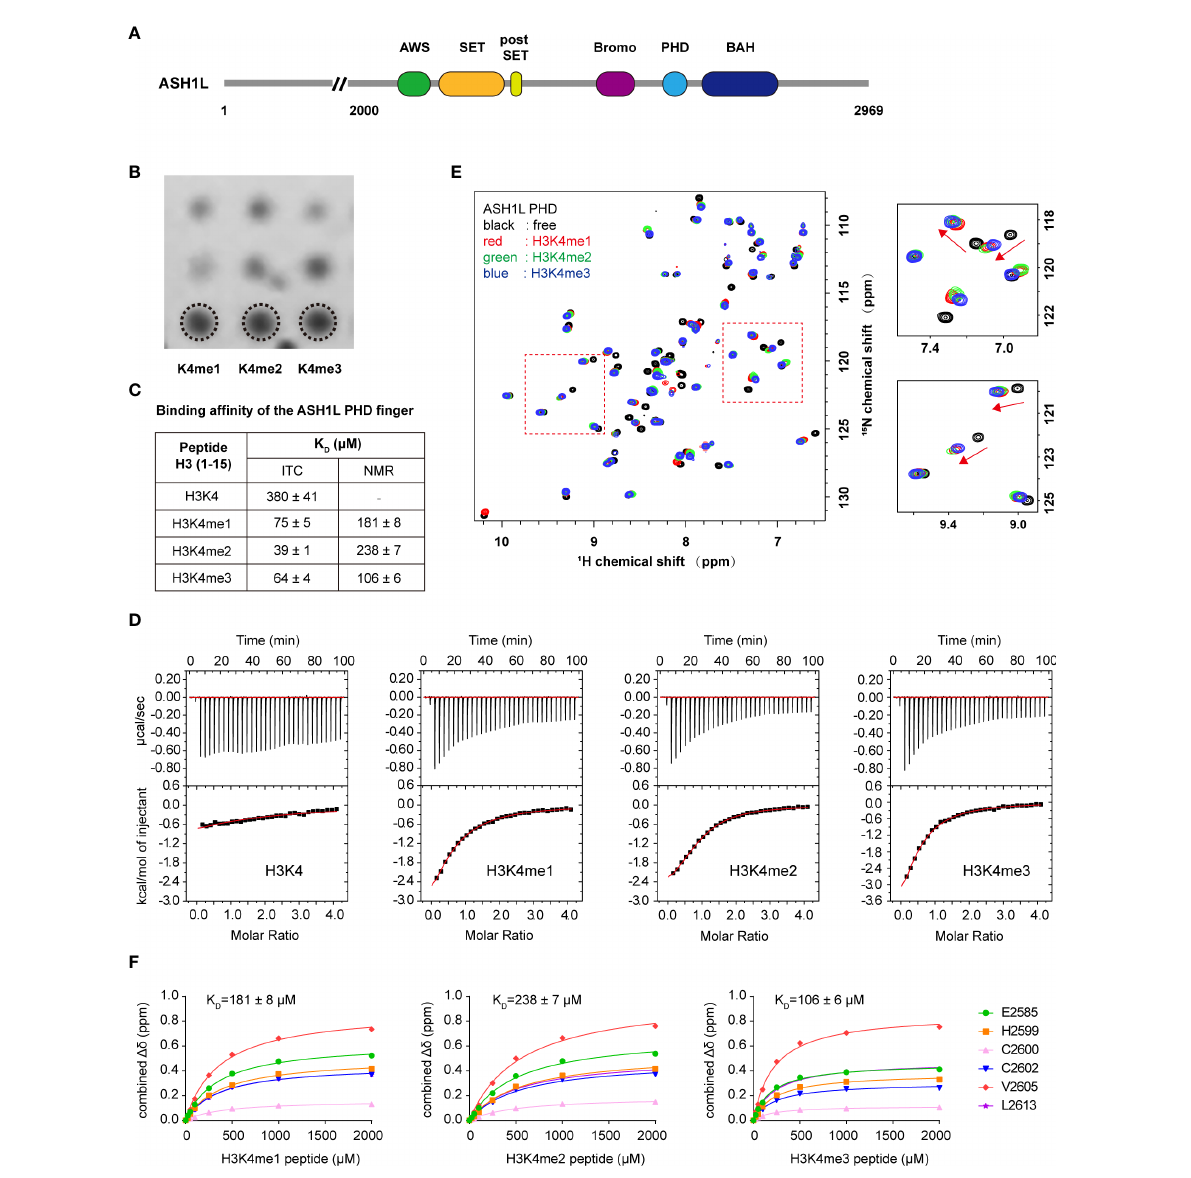
FIGURE 1 ASH1L PHD fi nger shows comparable binding af fi nity to H3K4me1/me2/me3. (A) Schematic representation of ASH1L protein. (B) Histone peptide array probed with the His-tagged ASH1L PHD fi nger. (C) Binding af fi nity of ASH1L PHD for the indicated H3 (1 – 15) peptides measured by isothermal titration calorimetry (ITC) and NMR titration. (D) Representative binding carves used to determine the K D values by ITC. (E) Superimposed ¹H, 15 N HSQC spectra of the ASH1L PHD fi nger collected upon titration with the indicated peptides in a protein – peptide molar ratio of 1: 5. Spectra are color-coded according to different peptides. Arrows indicate chemical shift changes. (F) Representative saturation curves used to determine the K D values by NMR titration. The saturation curves were calculated using a single-site binding equilibrium